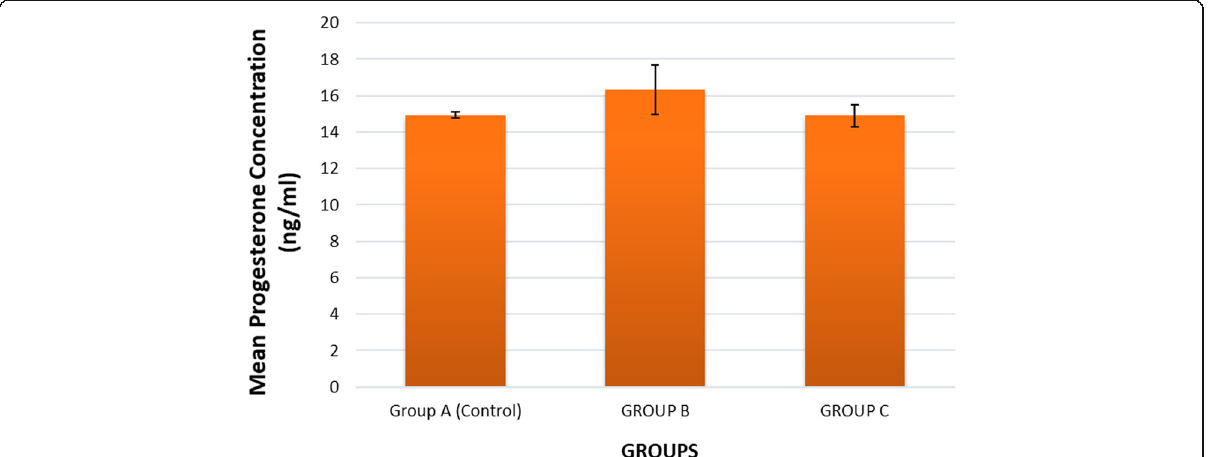
Fig. 3 Effect of perinatal β -cyp exposure on serum progesterone concentration of female F1 generation rats at sexual maturity. Results are given as mean ± SEM for 5 rats in each group. Experimental groups are compared with group A (control). No significant difference at a 95% confidence interval ( p > 0.05). Groups A, B, and C represent the control (given 0.5 ml olive oil), 15 mg/kg β -cyp-treated rats, and 30 mg/kg β -cyp-treated rats, respectively